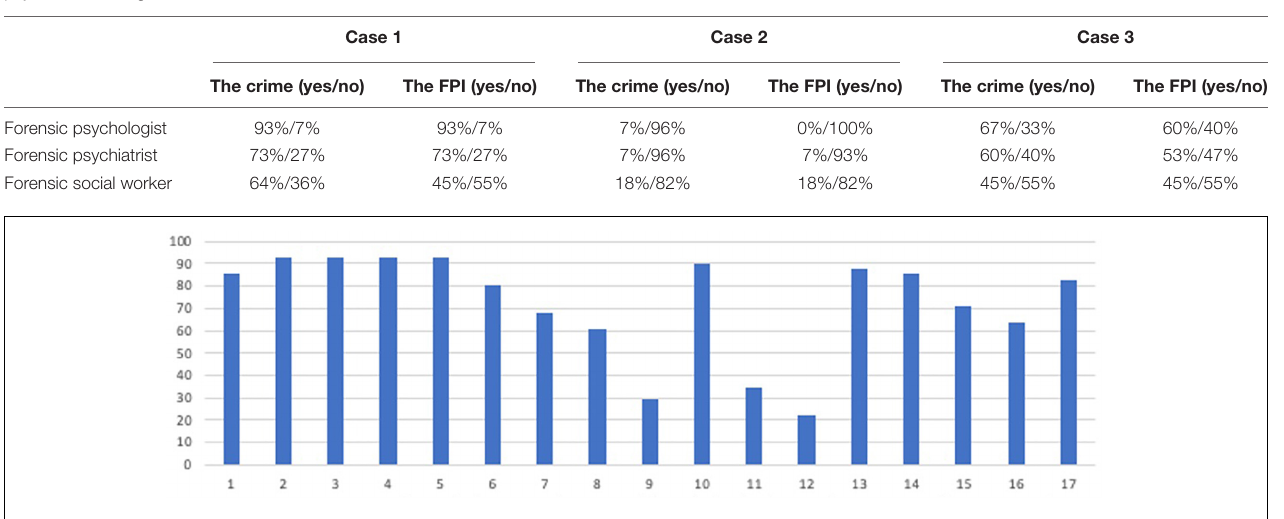
TABLE 3 | Percentage of the professional groups’ assessment regarding severe mental disorder in each case at the time of the crime and at the forensic psychiatric investigations.